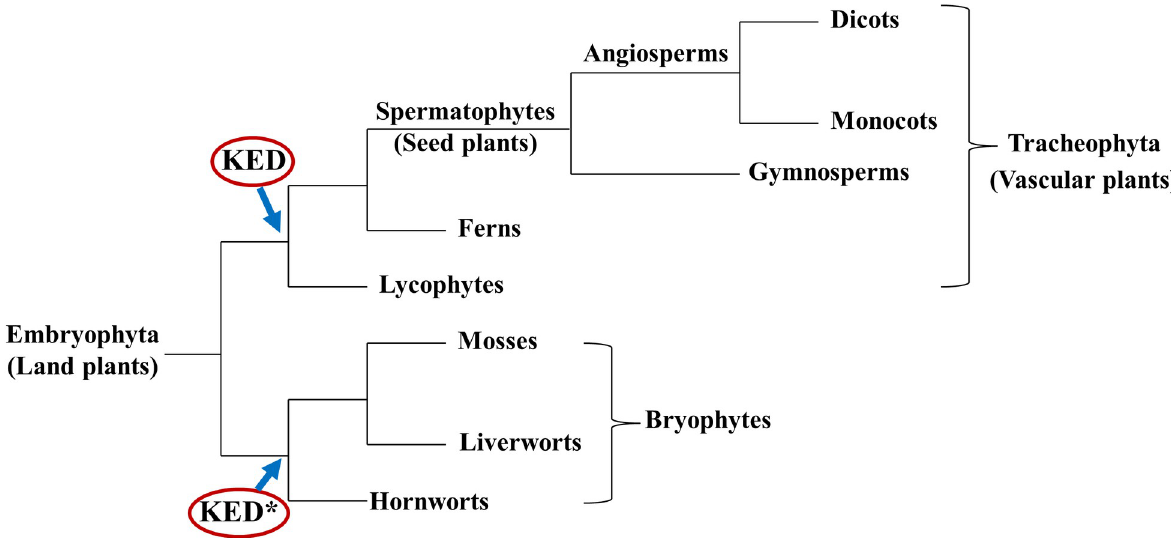
Fig 5. Proposed emergence of KED genes along taxonomic lineages of land plants. The KED genes likely appeared after emergence of vascular plants ca 450 mya and are conserved throughout Tracheophyta ( KED ), which are distinct from the KED-rich protein genes ( KED � ) found in mosses, liverworts and hornworts. The classification diagram is adapted from [21]. Branch length is not scaled to divergent